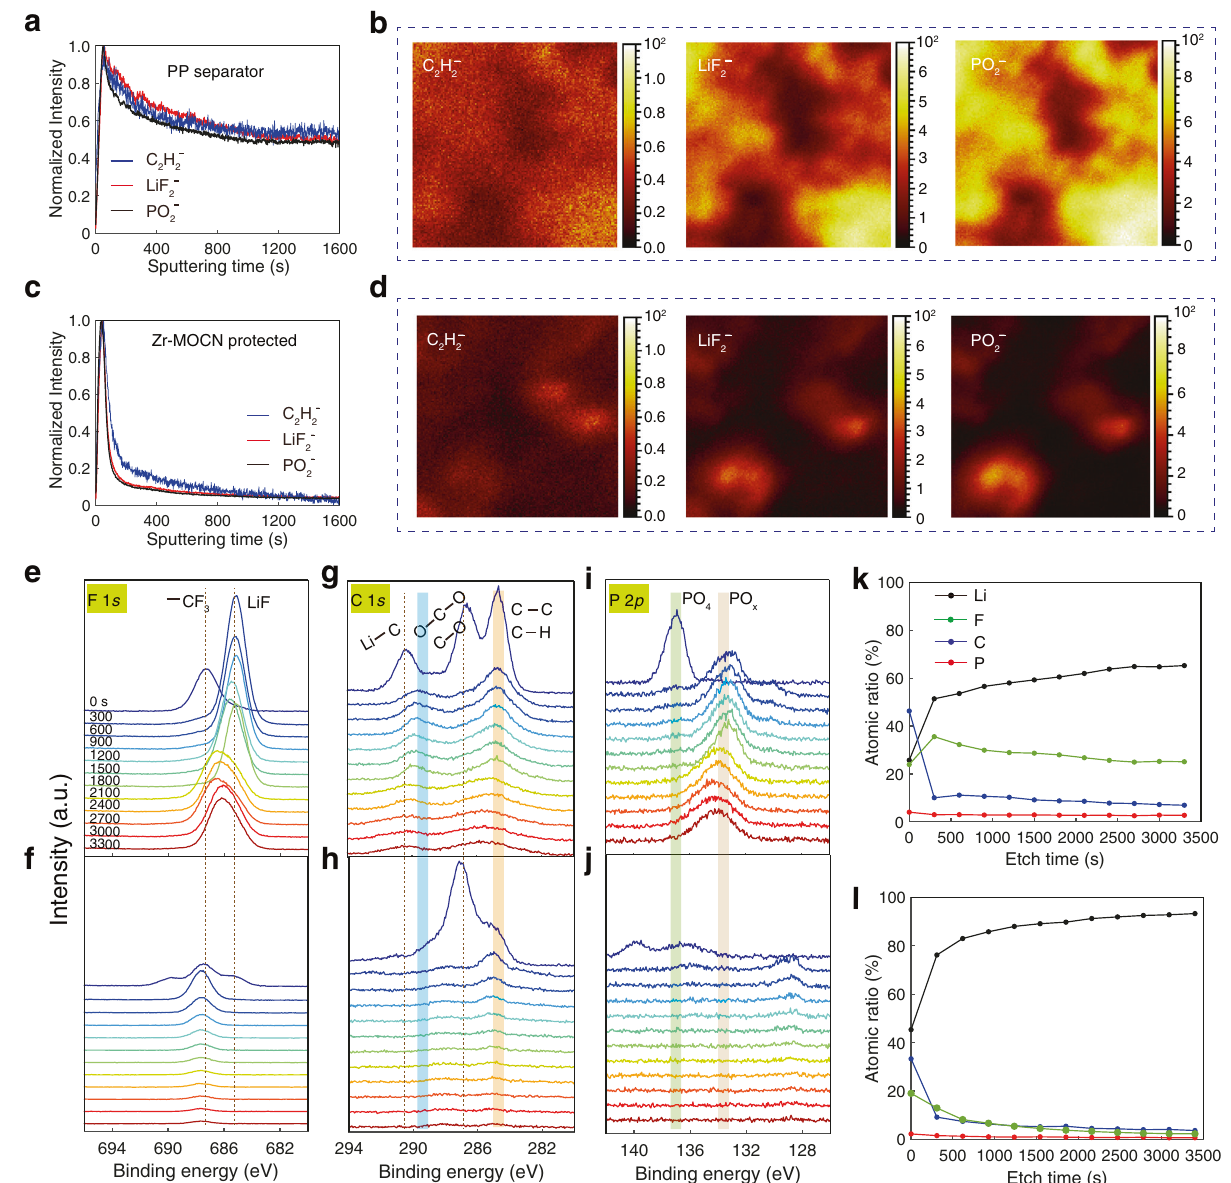
Fig. 4 Characterization of chemical compositions on the cycled lithium metal electrodes by ToF-SIMS and XPS spectra. a , c ToF-SIMS normalized (to maximum) depth pro fi ling of several typical second ion fragments on the cycled lithium metal electrode surface of the pristine PP and Zr-MOCN protected areas, respectively. b , d ToF-SIMS chemical maps of second ion fragments with 1600 s of sputtering in the lithium metal electrodes cycled in the PP and Zr- MOCN protected areas, respectively. e – j XPS spectra of F, C and P elements recorded different time of argon ion sputtering at cycled lithium metal electrode surface of the pristine PP (upper panel) and Zr-MOCN (lower panel) protected areas, respectively. k , l The corresponding depth pro fi les of the atomic concentration of Li, F, C, and P